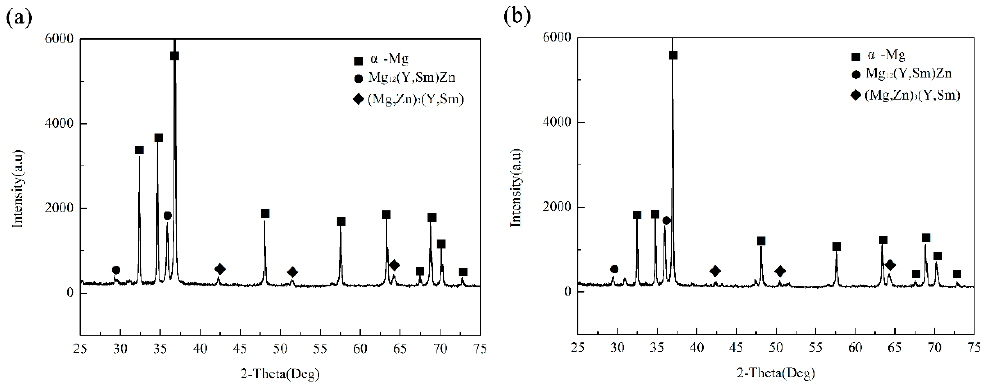
Figure 4. XRD patterns of the as-cast Mg-3Y-3.5Sm-2Zn-0.6Zr alloy: ( a ) Without UST; ( b ) with UST.